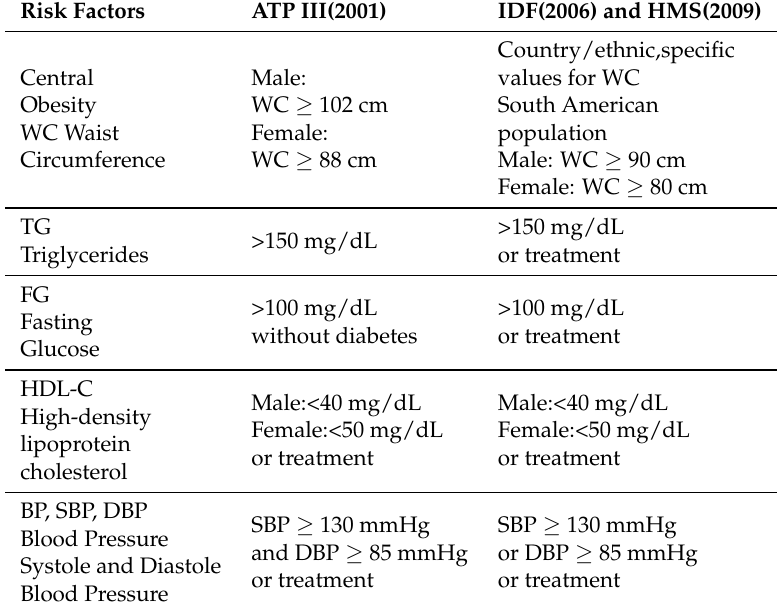
Table 1. Diagnosis